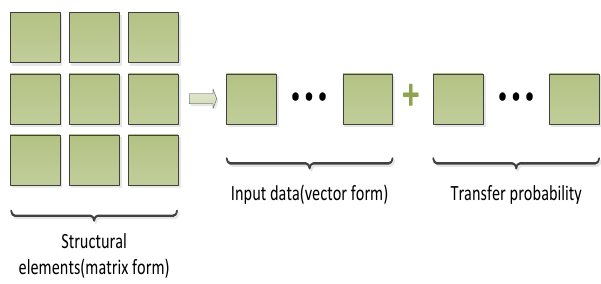
Figure 6. Form of data transformation.